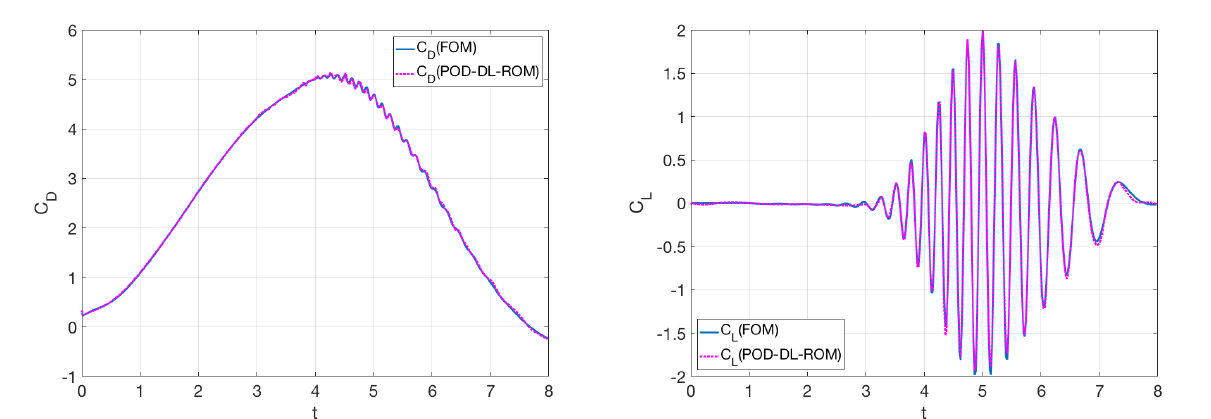
Figure 6. Test case 1: FOM and POD-DL-ROM drag ( left ) and lift ( right ) coefficients for the testing-parameter instance µ test =